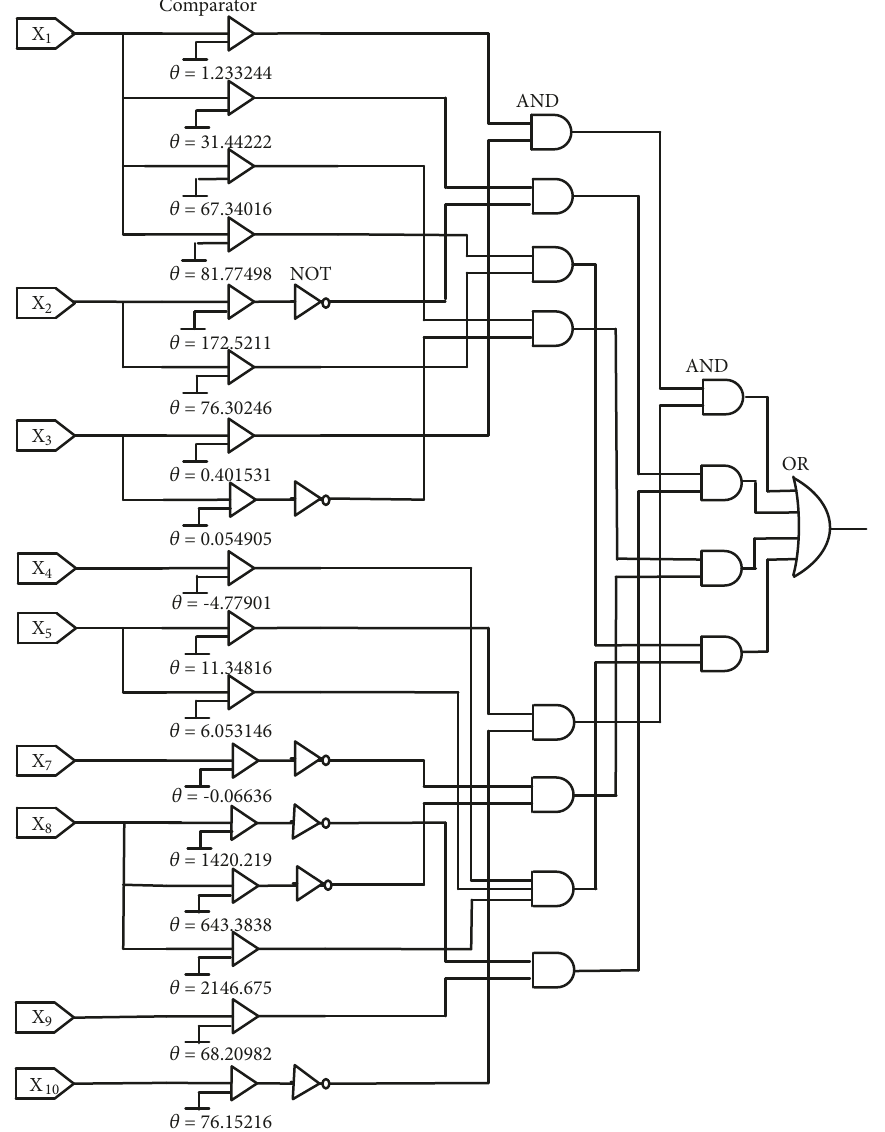
Figure 17: The logic circuit of the Distress data